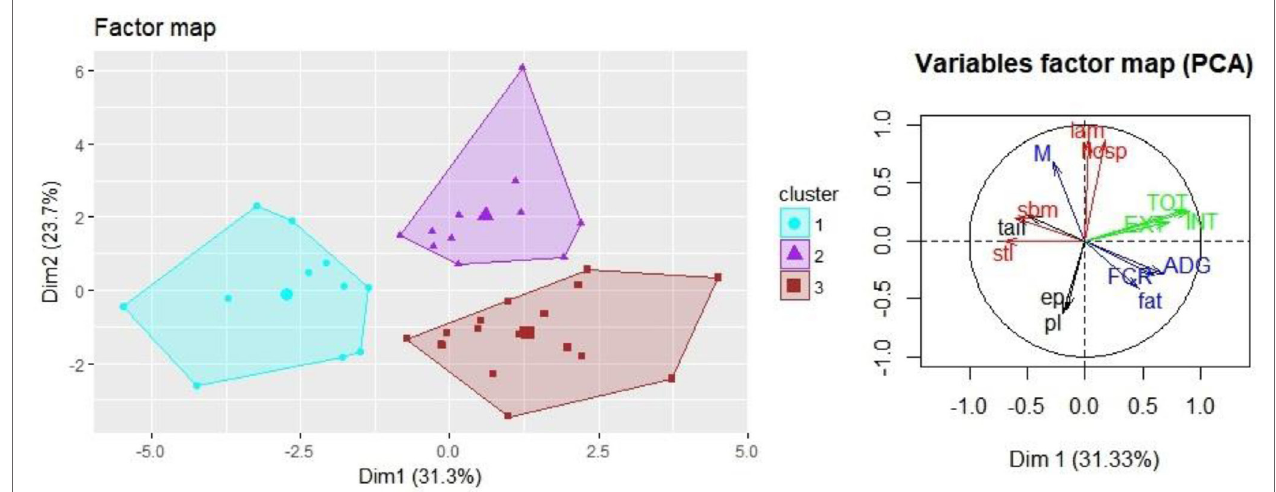
FigUre 2 | Principal component analysis (PCA) plot of the fattening farms (individual farms) and the variables on the two first components (CP1: 31.33%; CP2: 23.66%). Biosecurity [external (EXT), internal (INT), and total (TOT) biosecurity] is represented in green. The number of fattening pigs (fat) and the performance [average daily weight gain (ADG), feed conversion ratio (FCR), and mortality (MOR)] are represented in blue. Welfare outcomes [% pigs requiring hospitalization (hosp), lame pigs (lam), pigs with severe tail lesions (stl), and severe body marks (sbm)] are represented in red. Health indicators [% of enzootic pneumonia-like lesions (ep), pleurisy (pl), and tail-bitten lesions (tail)] are represented in black. A hierarchical clustering on the result of the PCA confirmed the partition in three clusters as the partition with the higher relative loss of inertia.